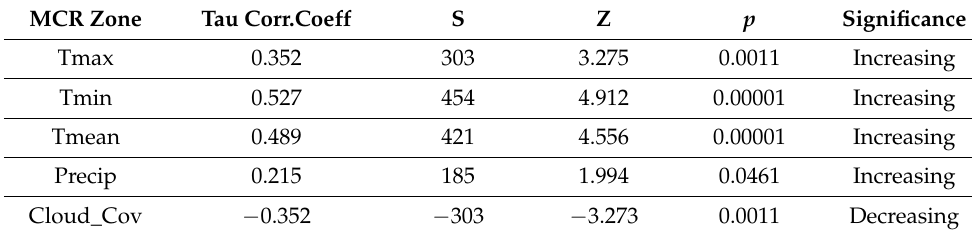
Table 9. Mann Kendall Trend Test of JJAS averaged climatic variable for MCR zone.